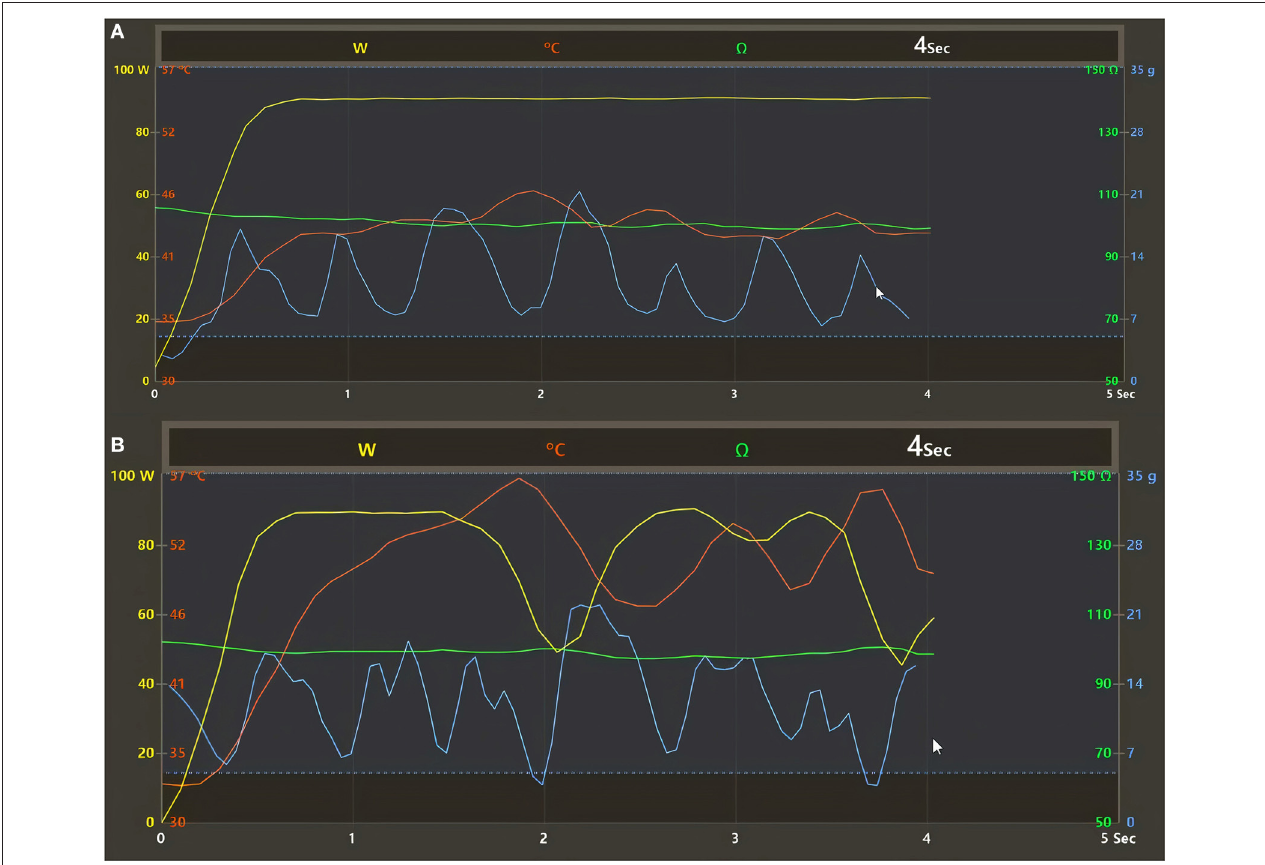
FIGURE 3 | (A,B) Regulation of the temperature control mode with the QDOT irrigated catheter and vHPSD algorithm as registered by the CARTO3 electroanatomical mapping system (Heart and Vascular Center, Semmelweis University). (A) The 90W of power is stably delivered throughout the 4s when the temperature registered by any thermocouples located distally around the catheter tip does not reach the target temperature (55 ◦ C) during lesion formation. (B) When the target temperature is reached, the ablation power is immediately downregulated by the vHPSD algorithm to prevent overheating of the tissue. Yellow line, delivered power; red line, temperature; blue line, contact force; green line,